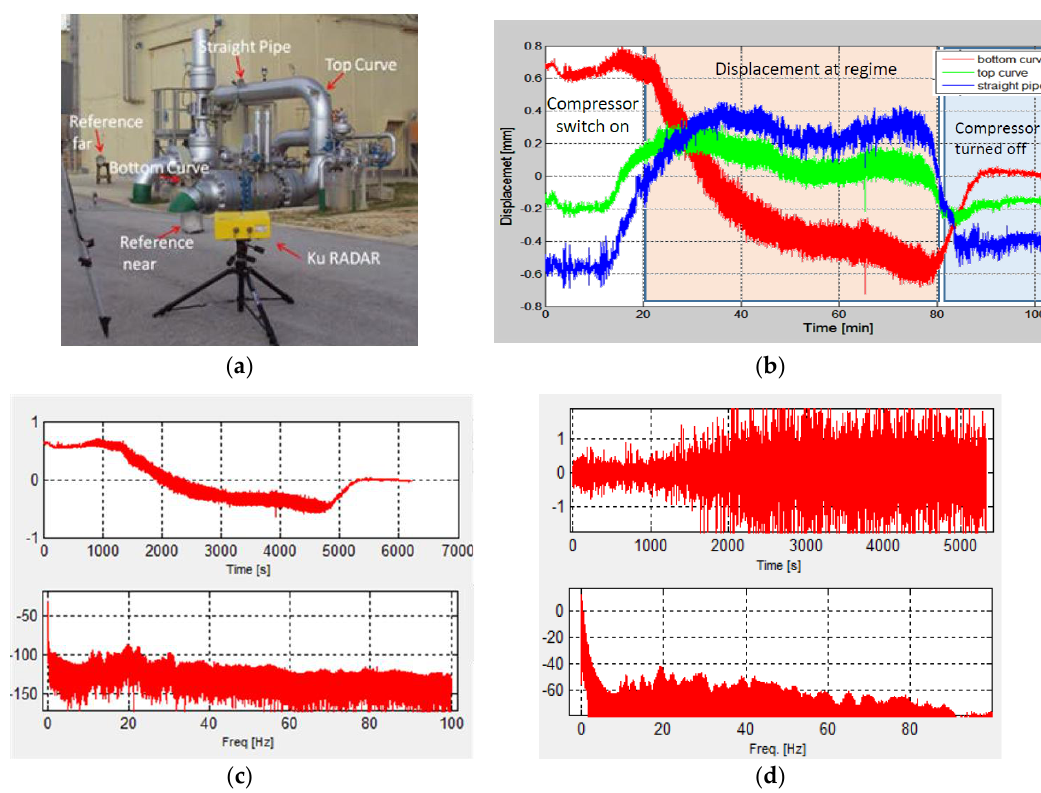
Figure 3. Monitoring pipes vibrations in a compression station. ( a , b ) Displacements measured by Radar on the corners marked on the picture, during an entire 100 min cycle from compressor switch-on to compressor switch-off. ( c ) Deformations measured by Radar ( upper panel ) and their spectra ( lower panel ). ( d ) Deformations measured by accelerometer: The low frequency components were not